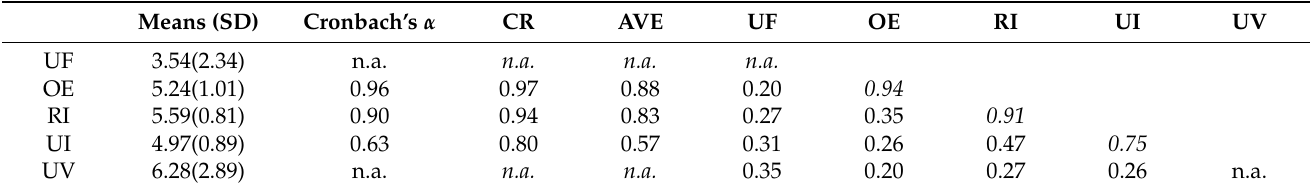
Table 2. Convergent validity, discriminant validity, and reliability of measurement model.